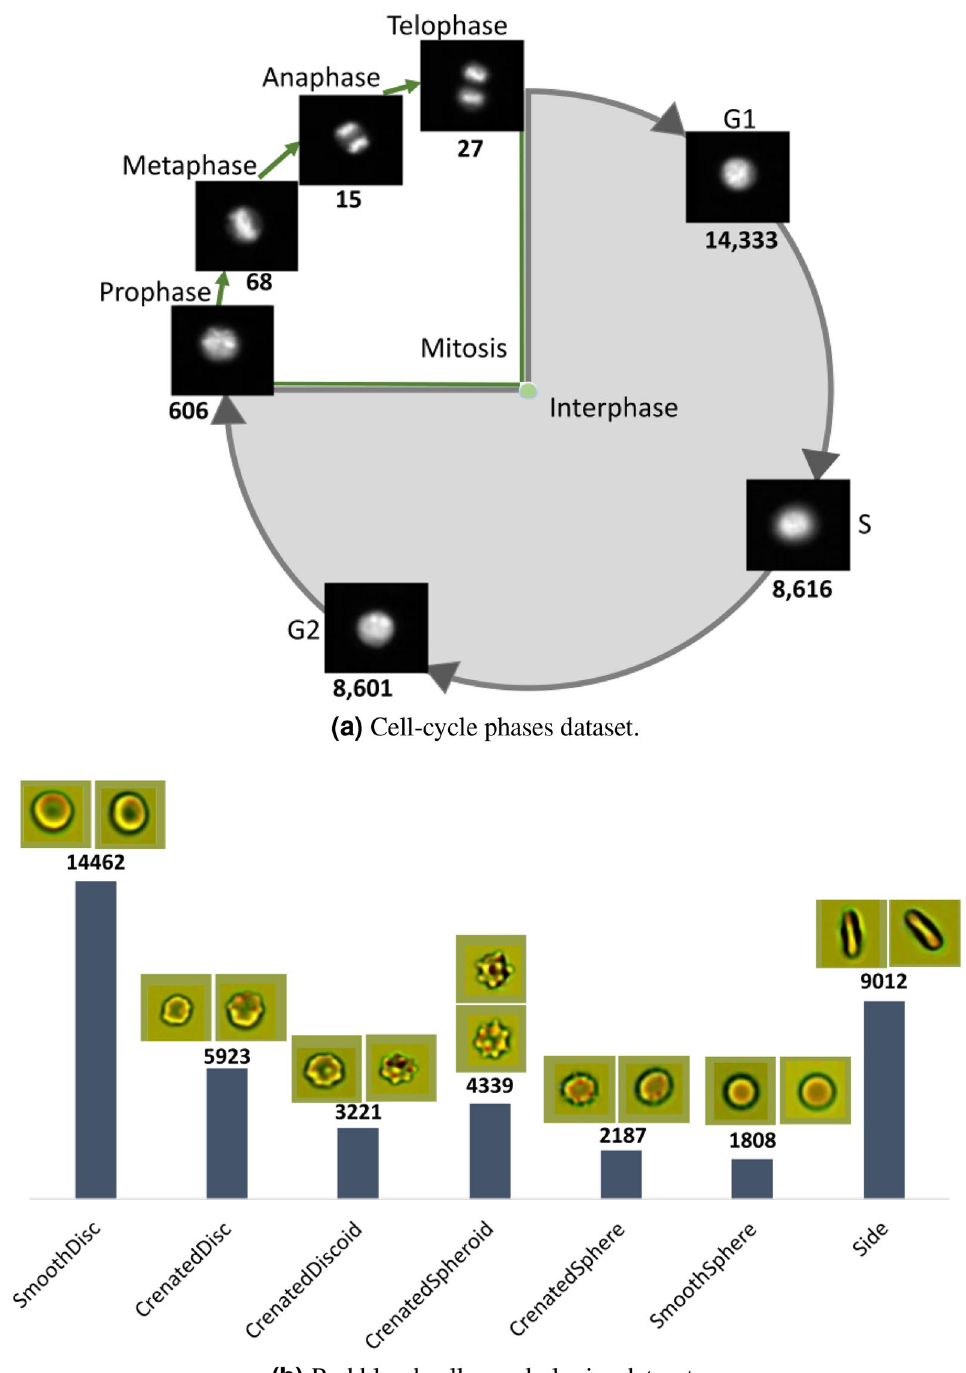
Figure 2. Class distribution of the two datasets used in this study, with the number below each image indicating the number of samples in that